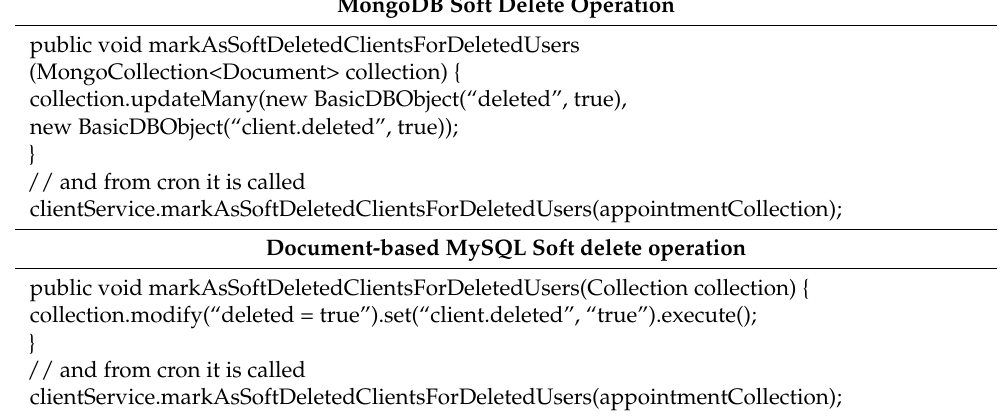
Table 9. Soft delete operation.